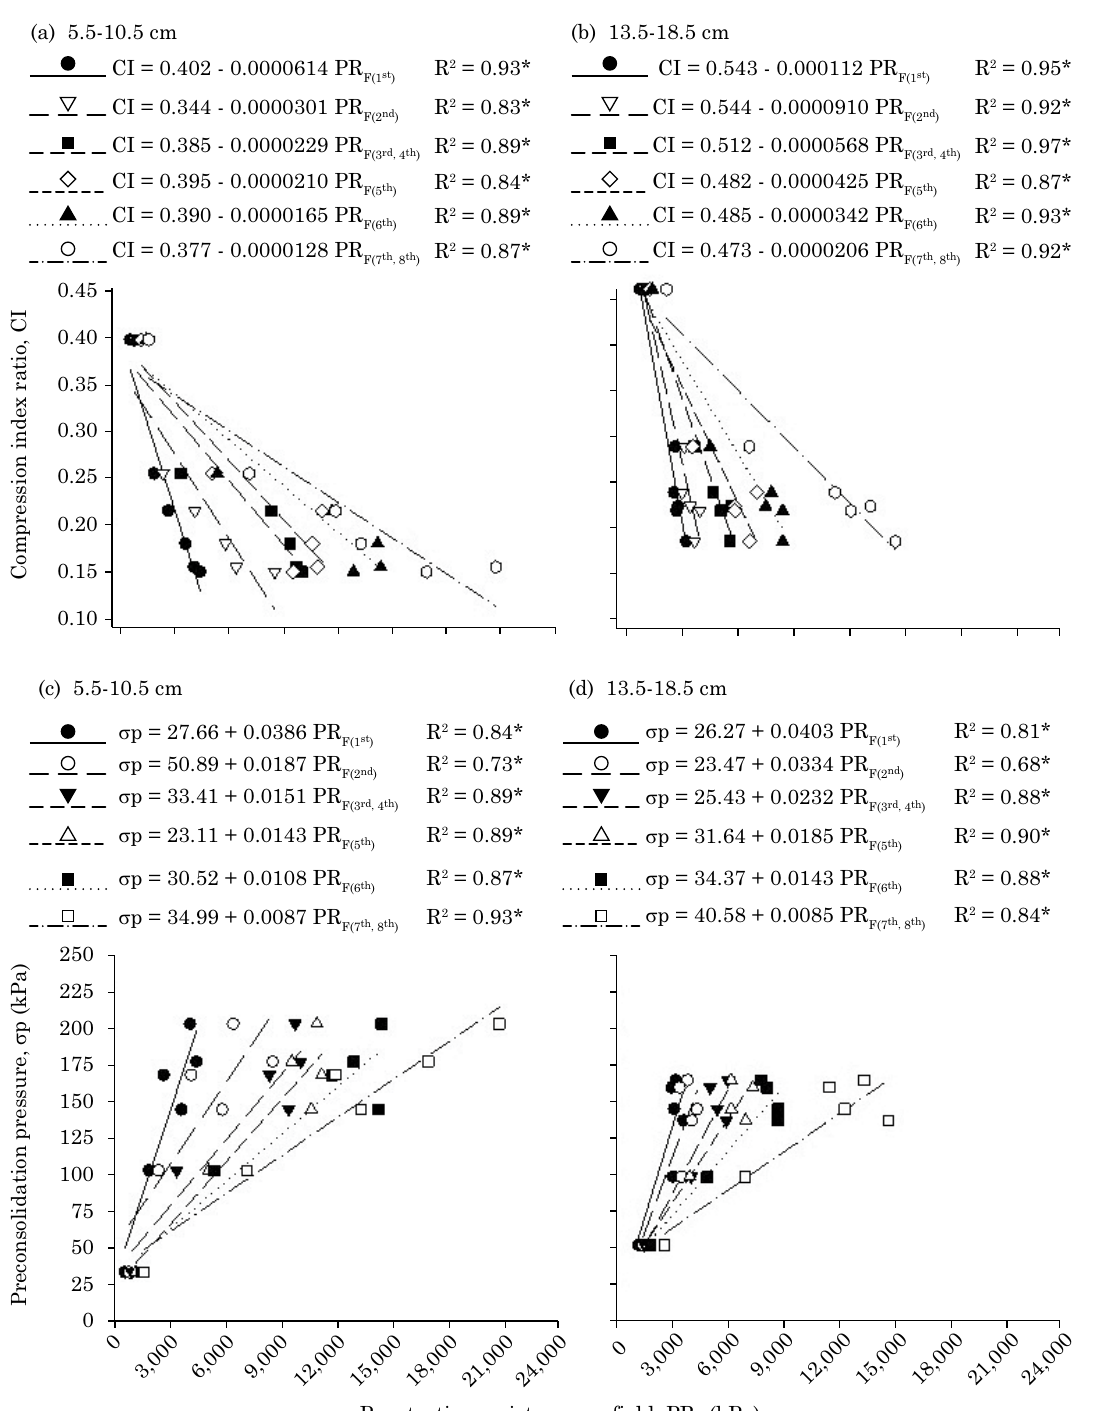
Figure 6. Correlation between compression index ratio (a, b) and preconsolidation pressure (c, d) with soil penetration resistance, using an impact penetrometer at different water content ranges of a Rhodic Eutrudox in the 5.5-10.5 cm (a, c) and 13.5-18.5 cm (b, d)